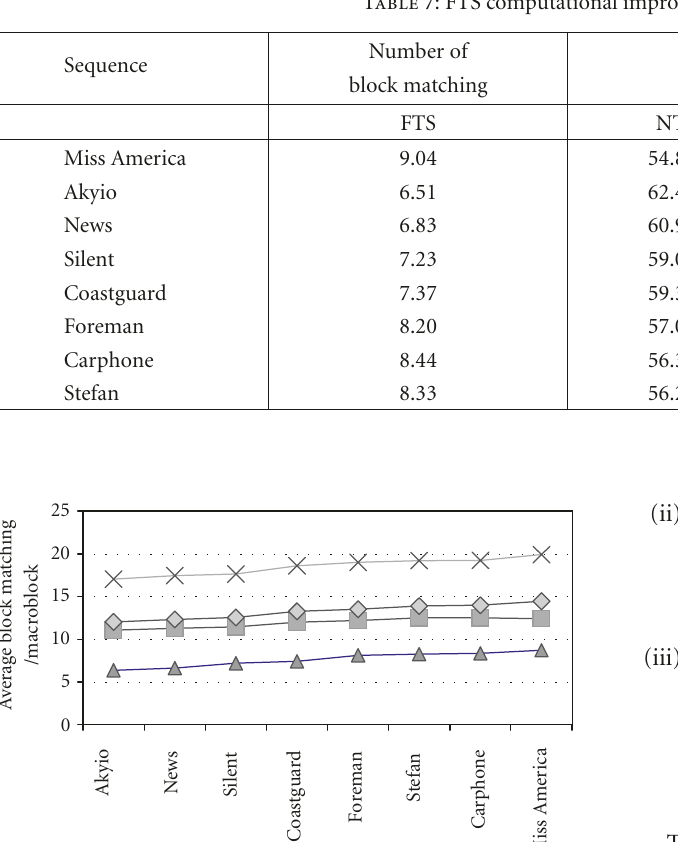
Figure 7: PSNR value per frame. Table 7: FTS computational improvement percentage.